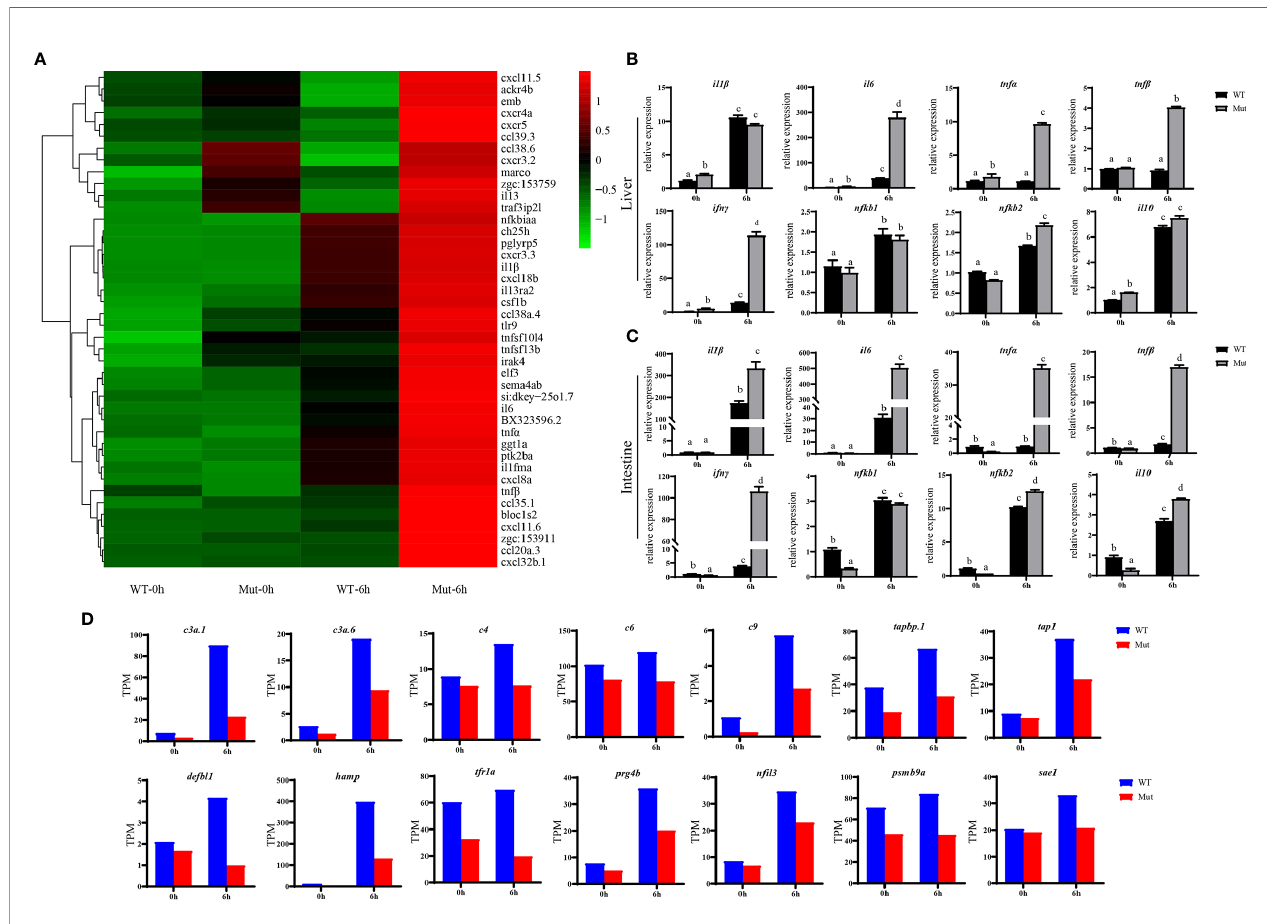
FIGURE 4 | Congenital asplenia induces excessive systemic in fl ammation after vaccination in zebra fi sh. (A) The expression level of in fl ammatory cytokines/ chemokines displayed with a heat map. (B) The expression of in fl ammation-related genes in liver after vaccination by qRT-PCR. (C) The expression of in fl ammation- related genes in intestine after vaccination by qRT-PCR. (D) The expression level of other important immune-related genes by RNA-seq. Different letters (a, b, c, etc.) indicate signi fi cant differences ( p <